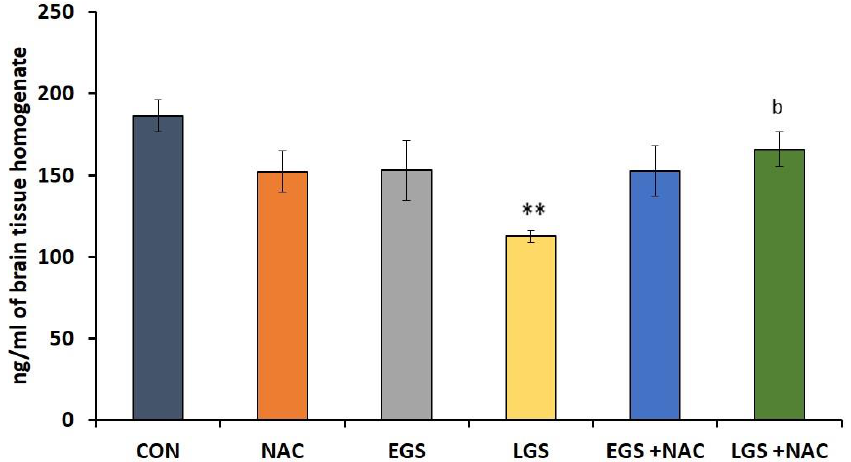
Figure 2. Effect of prenatal stress and NAC on whole brain homogenate dopamine levels (nmol/mL) at PND 36 in rat offspring. One-way ANOVA, Tukey-Kramer Multiple Comparisons test, each bar represents mean ± SEM, n = 6. Data are expressed as mean ± SEM. CON vs. LGS, ** p < 0.01, LGS vs. LGS + NAC b p < 0.05.